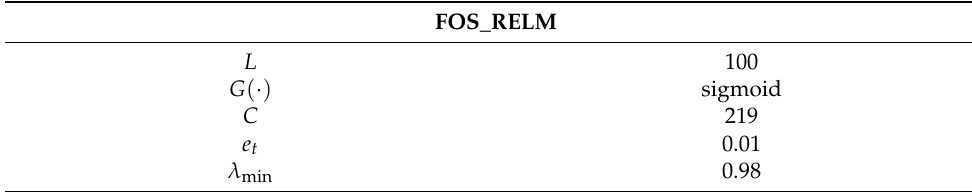
Table 1. FOS_RELM algorithm parameter settings. FOS_RELM L